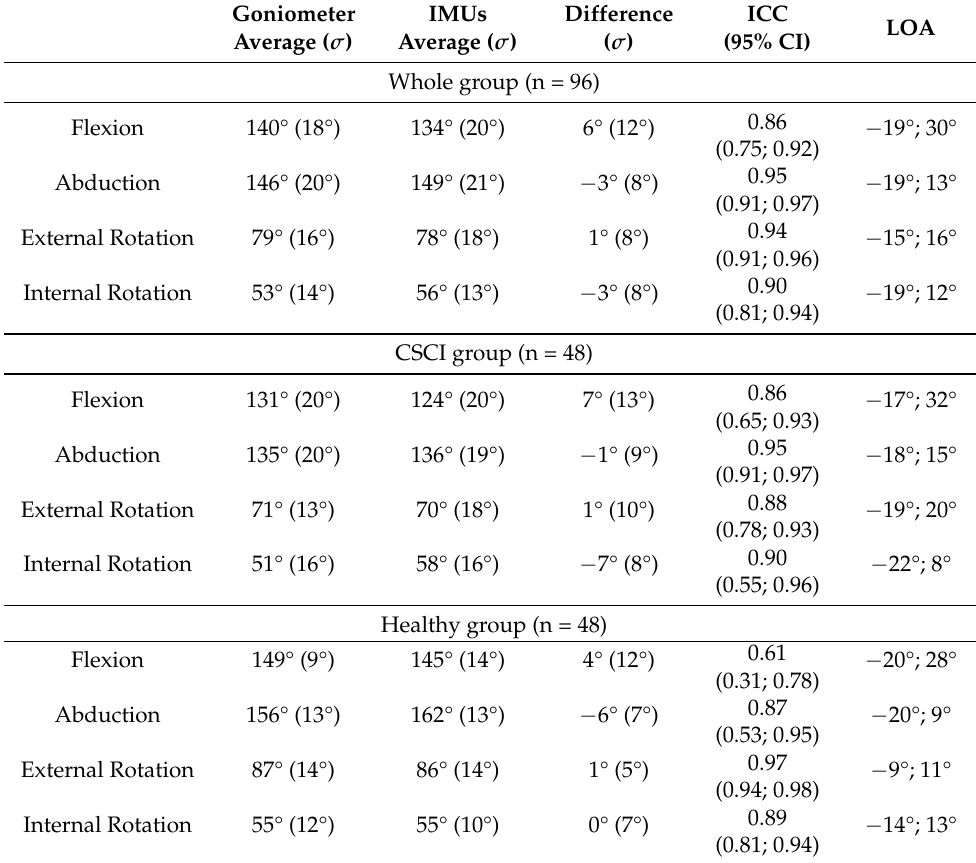
Table 6. Inter-instrument reliability indicators for goniometer and IMU measurements in the whole group, cervical spinal cord injury (CSCI) patients and healthy group.